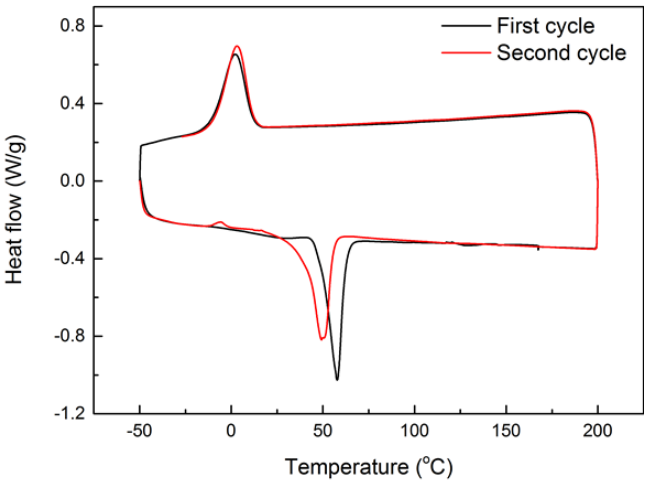
Figure 2. Differential scanning calorimetry (DSC) result of as-received pellet for two continuous thermal cycles.